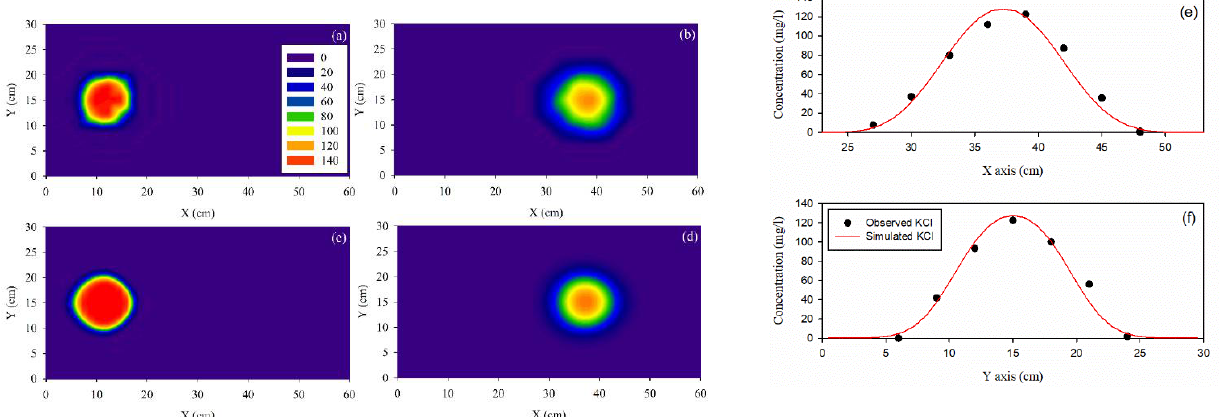
Figure 3. KCl plumes (unit of contour mg/L) observed ( a ) at the initial stage, ( b ) after 24 h; the simulated plumes ( c ) at the initial stage and ( d ) after 24 h; and ( e , f ) cross-section of concentration along the x- and y- axes after 24 h.